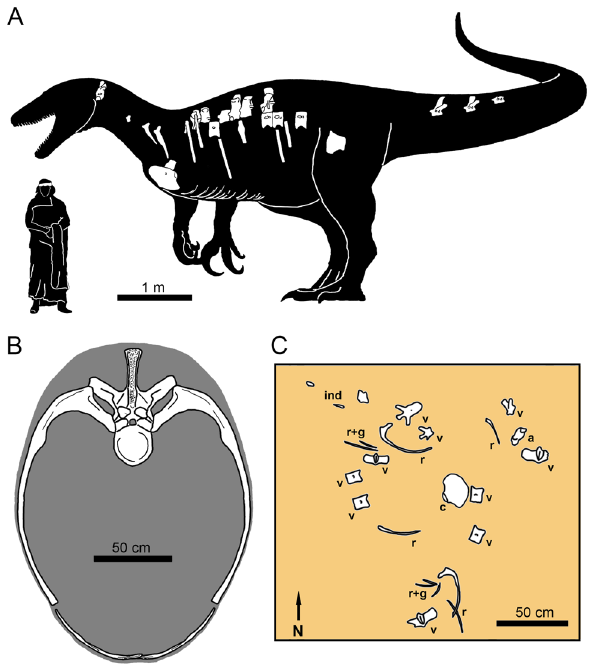
Figure 1. ( A ), silhouette of Maip macrothorax showing the preserved bones in white. ( B ), reconstruction of the thoracic cavity of Maip at level of D6. ( C ), interpretative drawing of the excavation of Maip showing the original disposition of the bones. Abbreviations: a, axis; c, coracoid; ind, indeterminate bone; g, gastralia; r, rib; v,